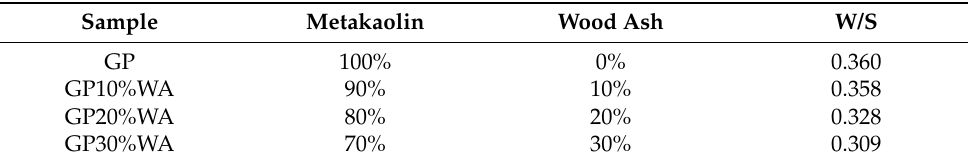
Table 1. Composition of the samples synthesized and W/S